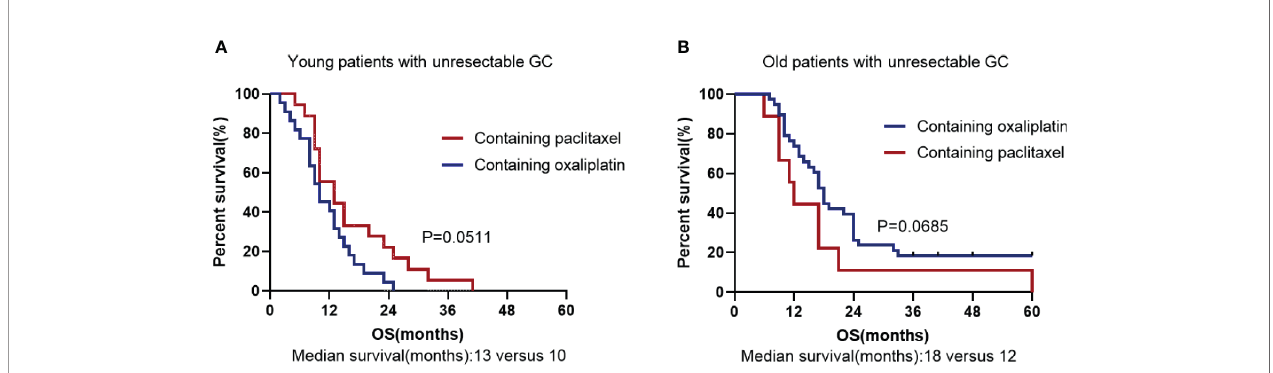
FIGURE 4 | Kaplan – Meier survival curve based on First-line chemotherapy for overall survival in unresected EOGC group (A) and LOGC group (B) . (A) The fi rst-line chemotherapy containing oxaliplatin or paclitaxel in EOGC patients with unresectable GC. (B) The fi rst-line chemotherapy containing oxaliplatin or paclitaxel in LOGC patients with unresectable